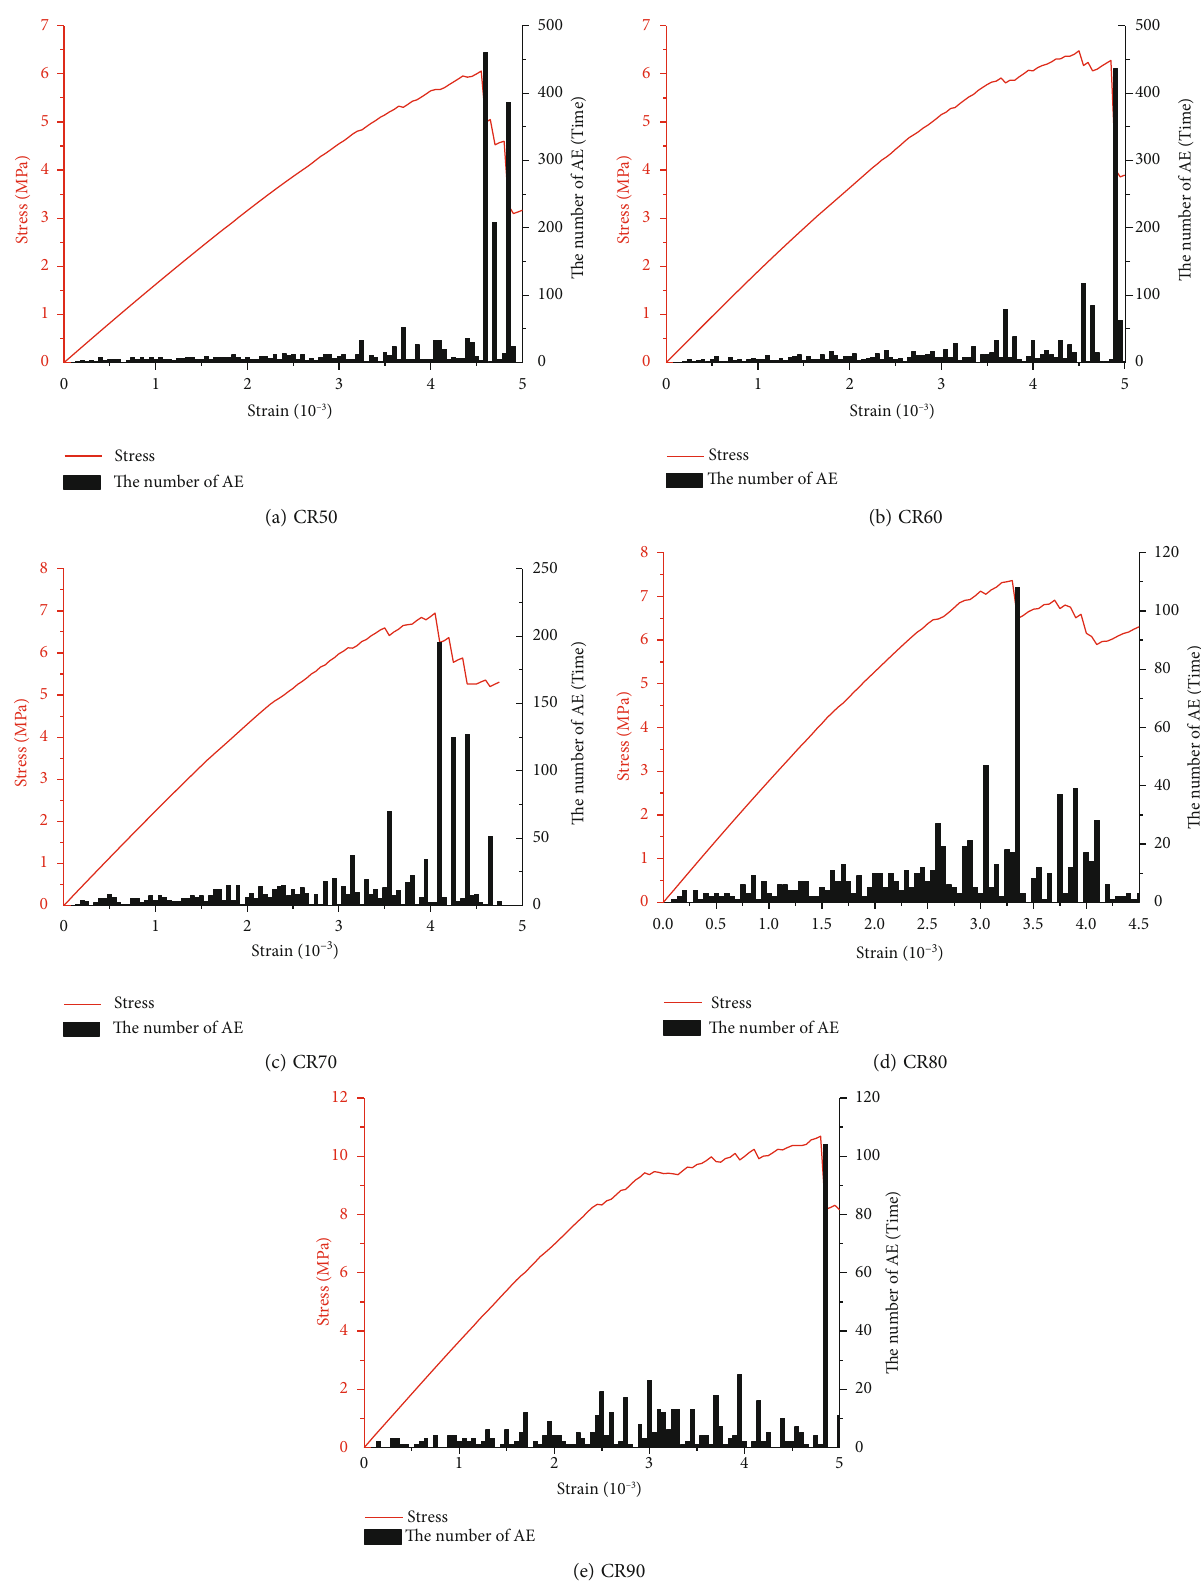
Figure 10: AE curves of samples not pressurized with